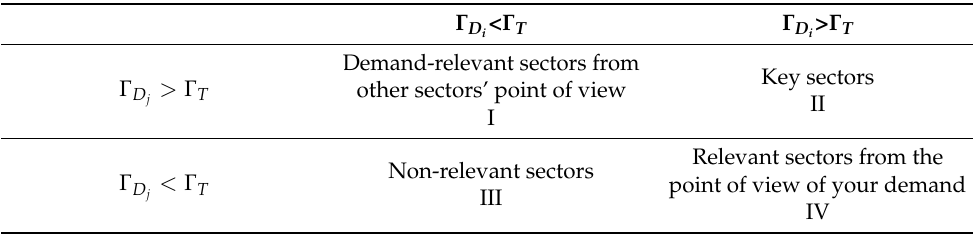
Table 2. Classification of sectors by the elasticity of water demand.